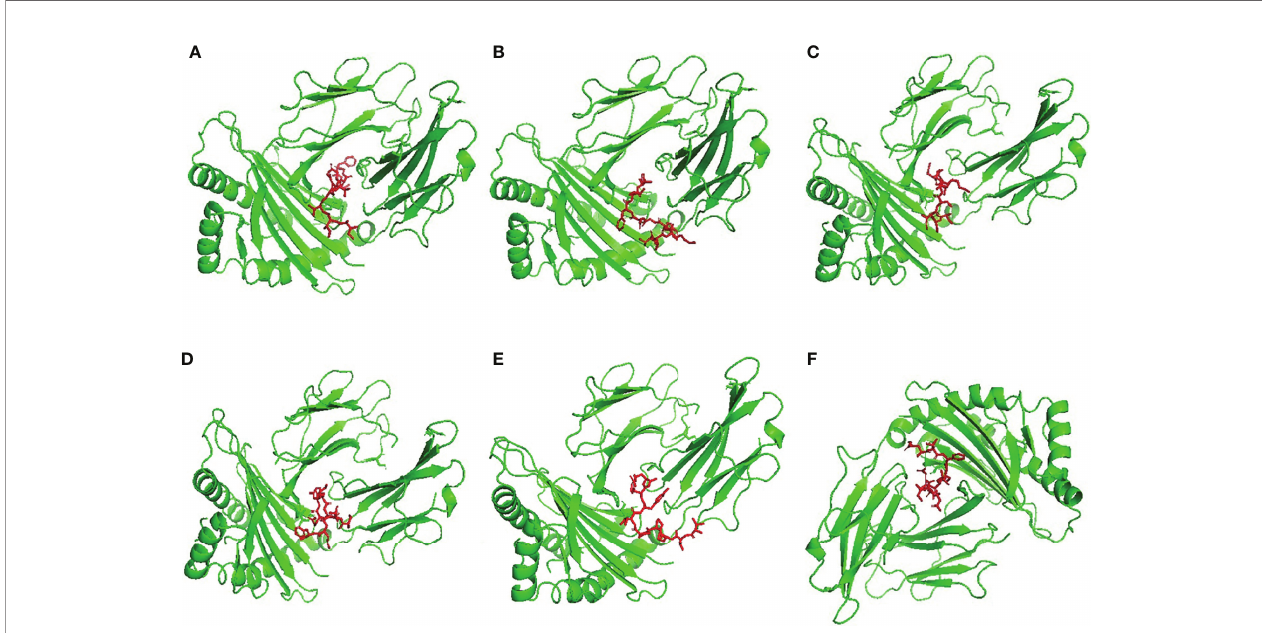
FIGURE 2 | Structural positions of MHC-I epitopes (red color) in 3-dimensional structure of HLA-A*11:01 (green color), structures (A – F) are for epitopes number 1,2,3,4,5 and 6 respectively from Table 4 .